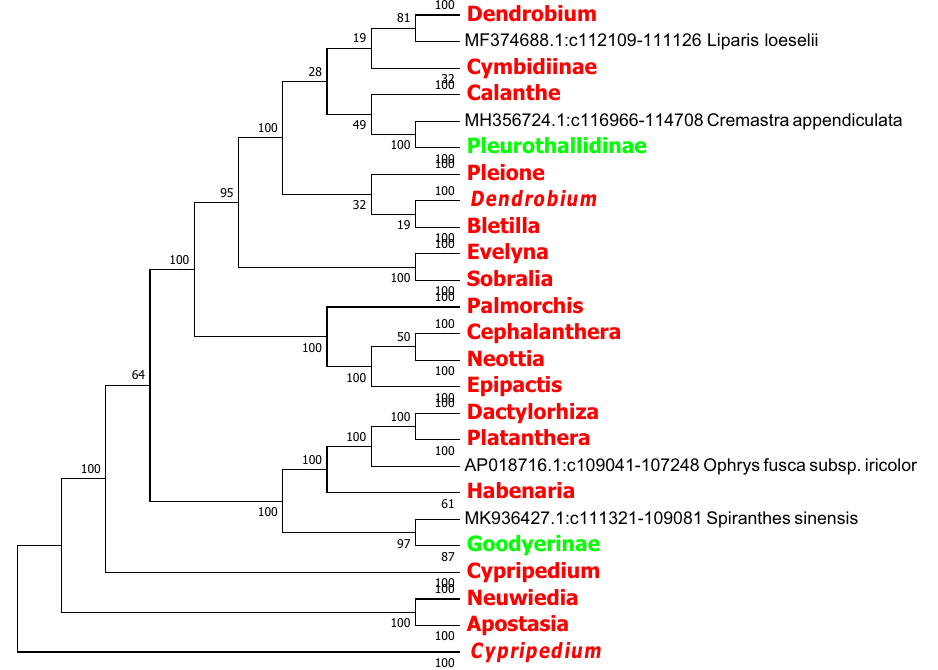
Figure 8. The NJ tree of Orchidaceae from analysis of the ndhF + ycf1 sequence based on the K2P model. Names tagged in red indicates the genus and tagged in green showed the subtribe.